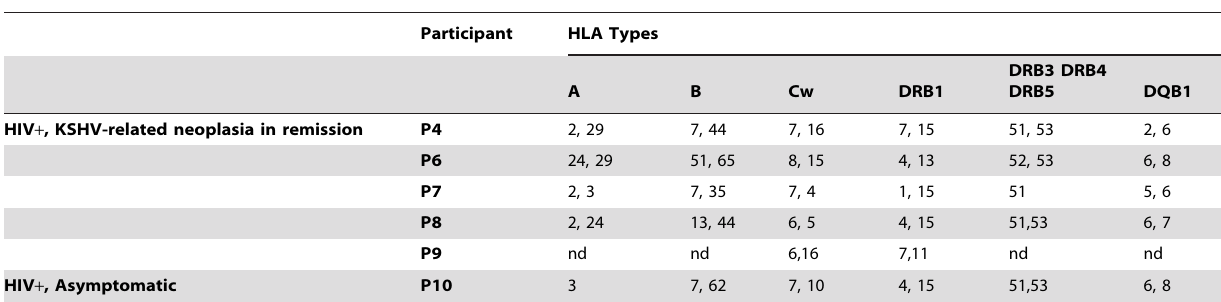
Table 3. HLA types of good